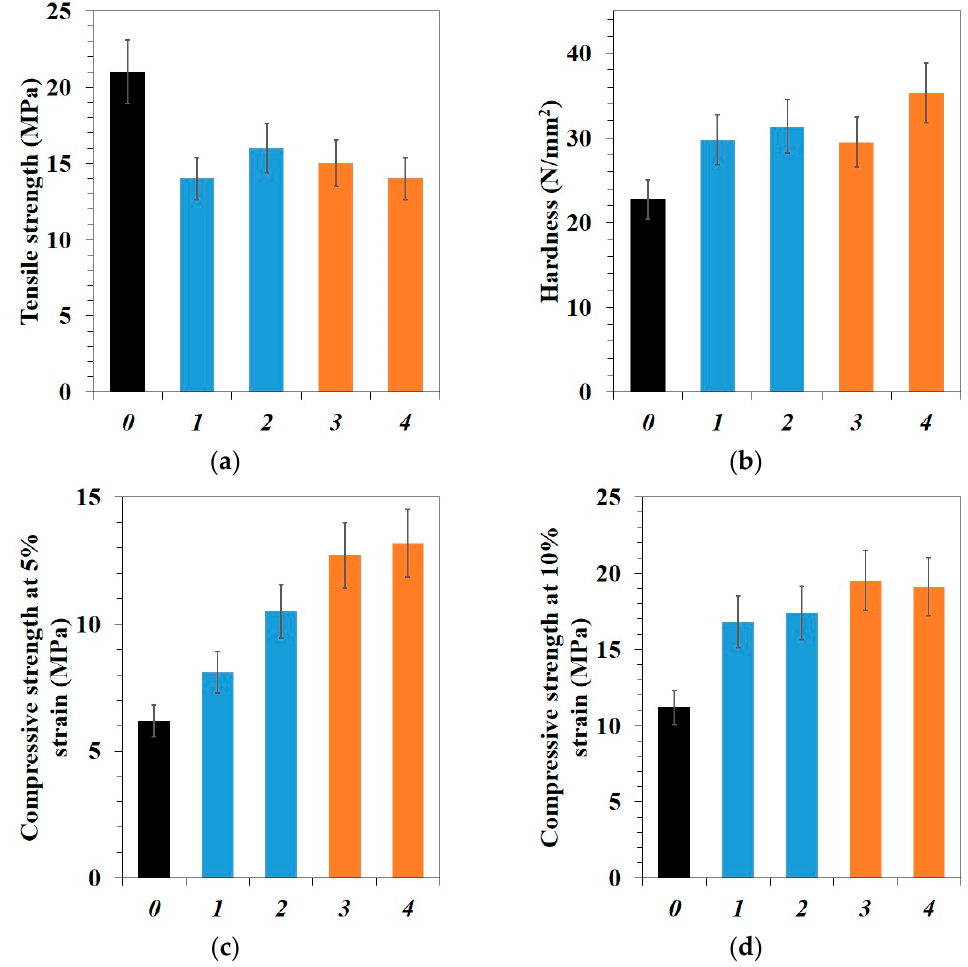
Figure 3. Mechanical properties of initial PTFE and PCM: ( a ) tensile strength; ( b ) hardness; ( c ) compressive strength at 5% relative strain; ( d ) compressive strength at 10% relative strain: 0 –initial PTFE; 1 –PTFE/CF/SiO 2 ; 2 –PTFE/CF/ZrO 2 ; 3 –PTFE/CF/SiO 2 /BN; 4 –PTFE/CF/ZrO 2 /BN.